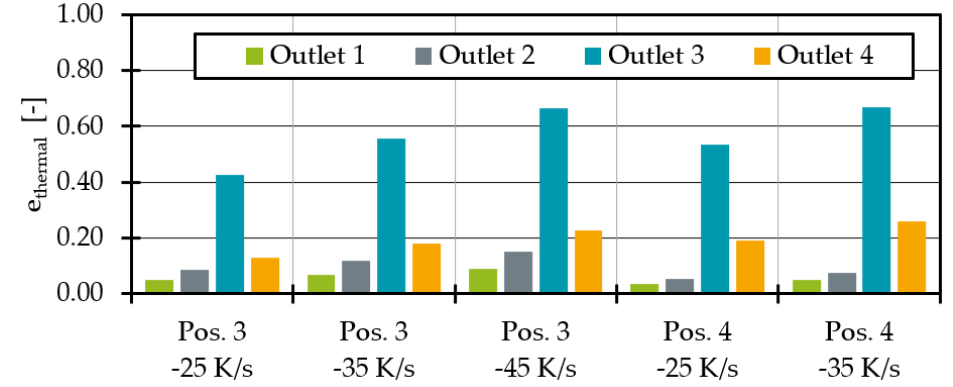
Figure 15. Thermal homogenisation indicator for different heat pipe performances and positions .